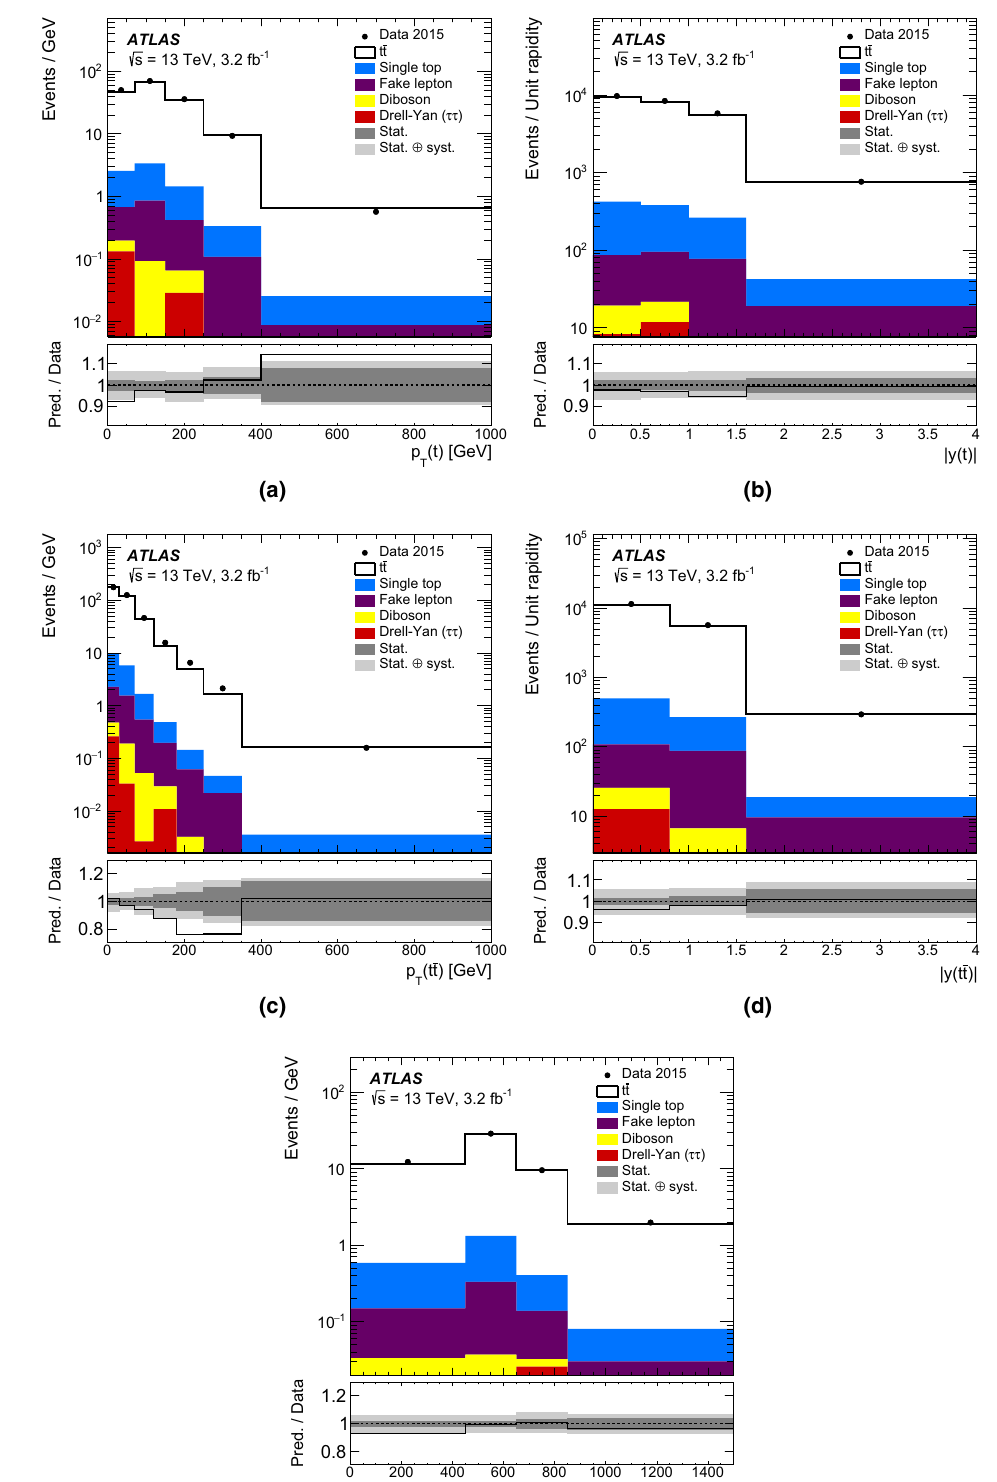
Fig. 2 Kinematic distributions for the p T ( t ) ( a ), | y ( t ) | ( b ), p T ( t ¯ t ) ( c ), t ¯ t | y t ¯ t | ( d ), and m ( t ¯ t ) ( e ) after reconstruction of the t ¯ t system. In all figures, the rightmost bin also contains events that are above the x - axis range. The uncertainty bands represent the statistical uncertainties